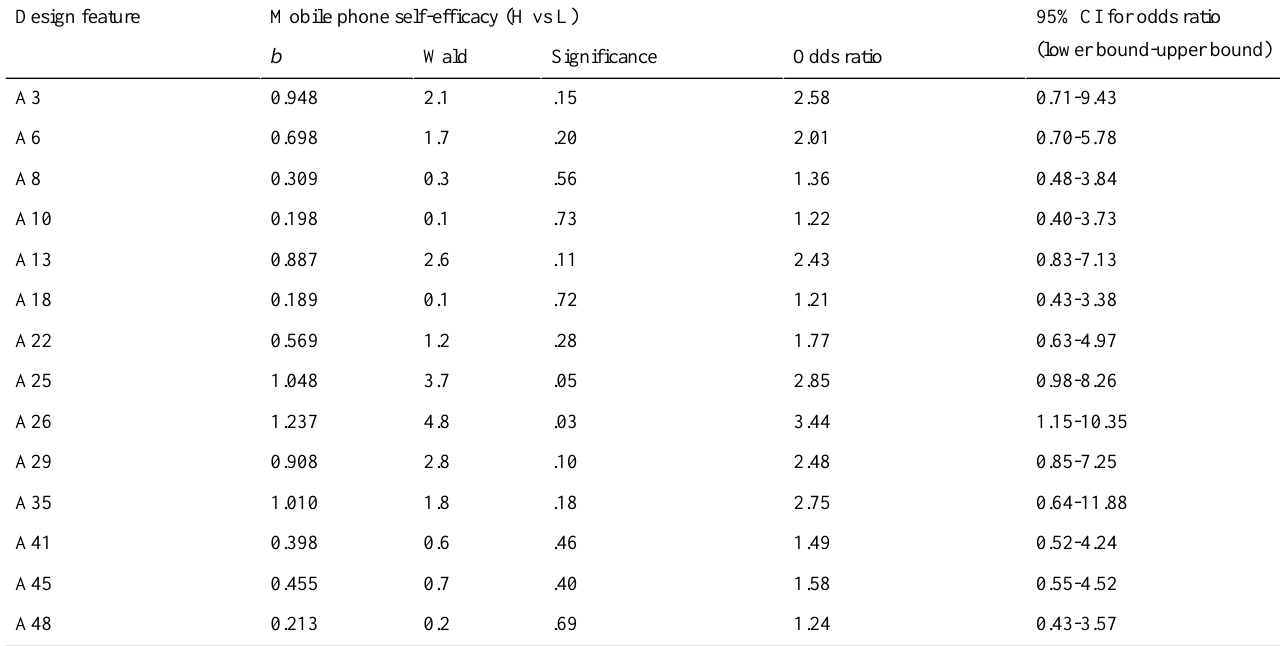
Table 16. Parameter estimates of change of mobile phone self-efficacy (MPSE) from low to high ( valued [ attractive + one-dimensional ] over indifferent